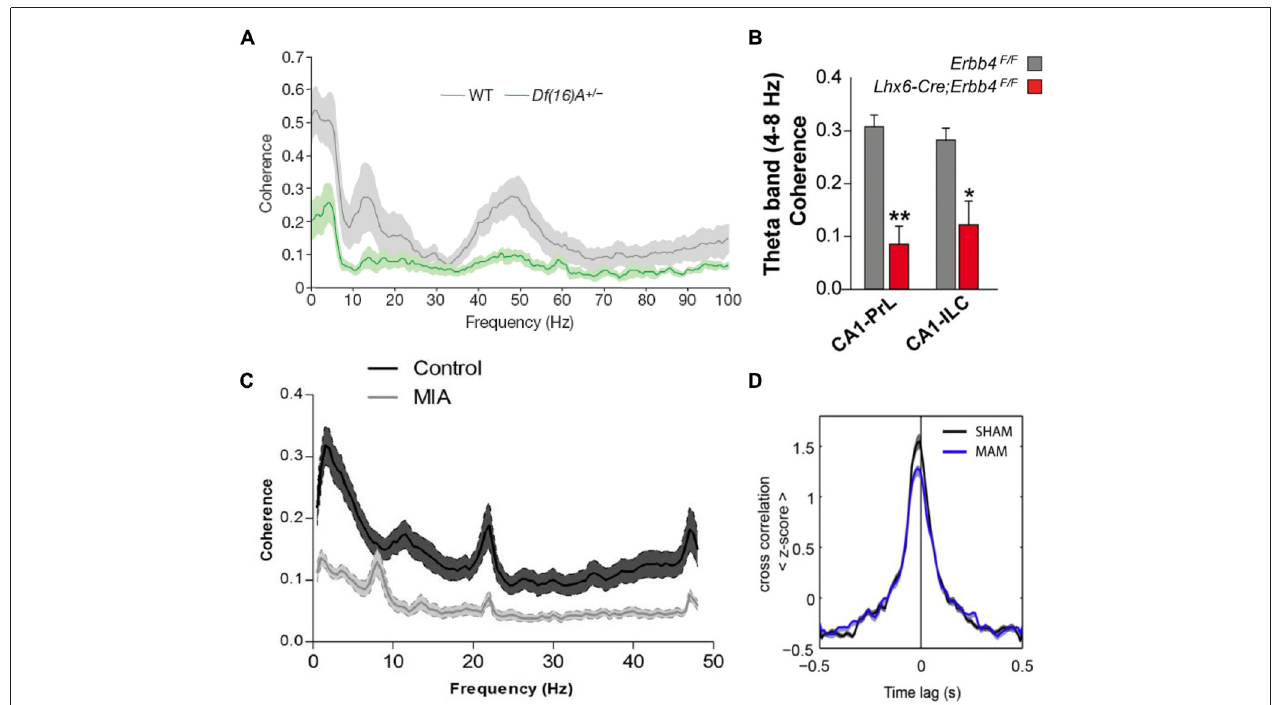
FIGURE 4 | Hippocampal-prefrontal interactions in animal models of schizophrenia. A reduction in hippocampal-prefrontal synchrony is seen across different animal models of schizophrenia representing diverse risk factors and pathophysiological mechanisms. (A) Decreased hippocampal-prefrontal local field potential (LFP) coherence in Df(16)A + / − mice, which model the human 22q11.2 microdeletion, during a SWM task (Sigurdsson et al., 2010). (B) Decreased hippocampal-prefrontal theta coherence in mice lacking the ErbB4 receptor on parvalbumin interneurons (Lhx6-Cre; Erbb4 F/F; Del Pino et al., 2013). (C) Decreased hippocampal-prefrontal LFP coherence in offspring of maternal immune activation (MIA)-treated rats (Dickerson et al., 2010). (D) Reduced cross-correlation between hippocampal-prefrontal cell pairs in offspring of methylazoxymethanol acetate (MAM)-treated rats, a neurodevelopmental model of schizophrenia, during slow-wave sleep (Phillips et al.,